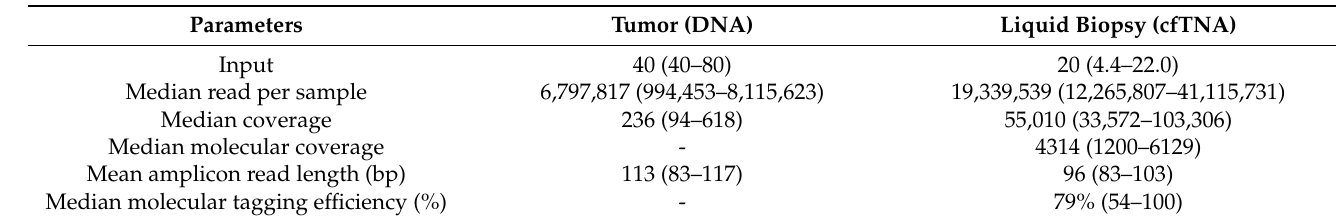
Table 2. Parameters of next-generation sequencing (NGS) for 145 pair tumor tissue and liquid biopsy. Parameters Tumor (DNA) Liquid Biopsy